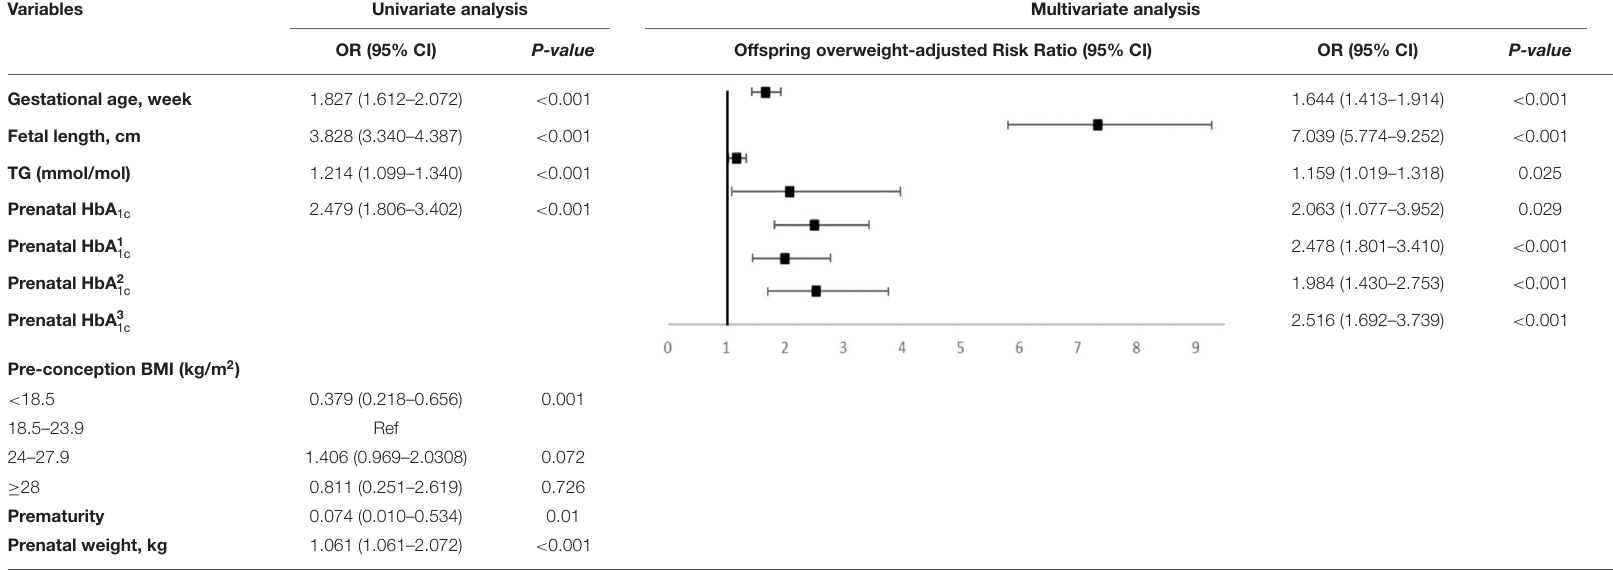
TABLE 4 | Univariate and Multivariate analysis of related factors of offspring macrosomia and LGA. Variables Univariate analysis Multivariate